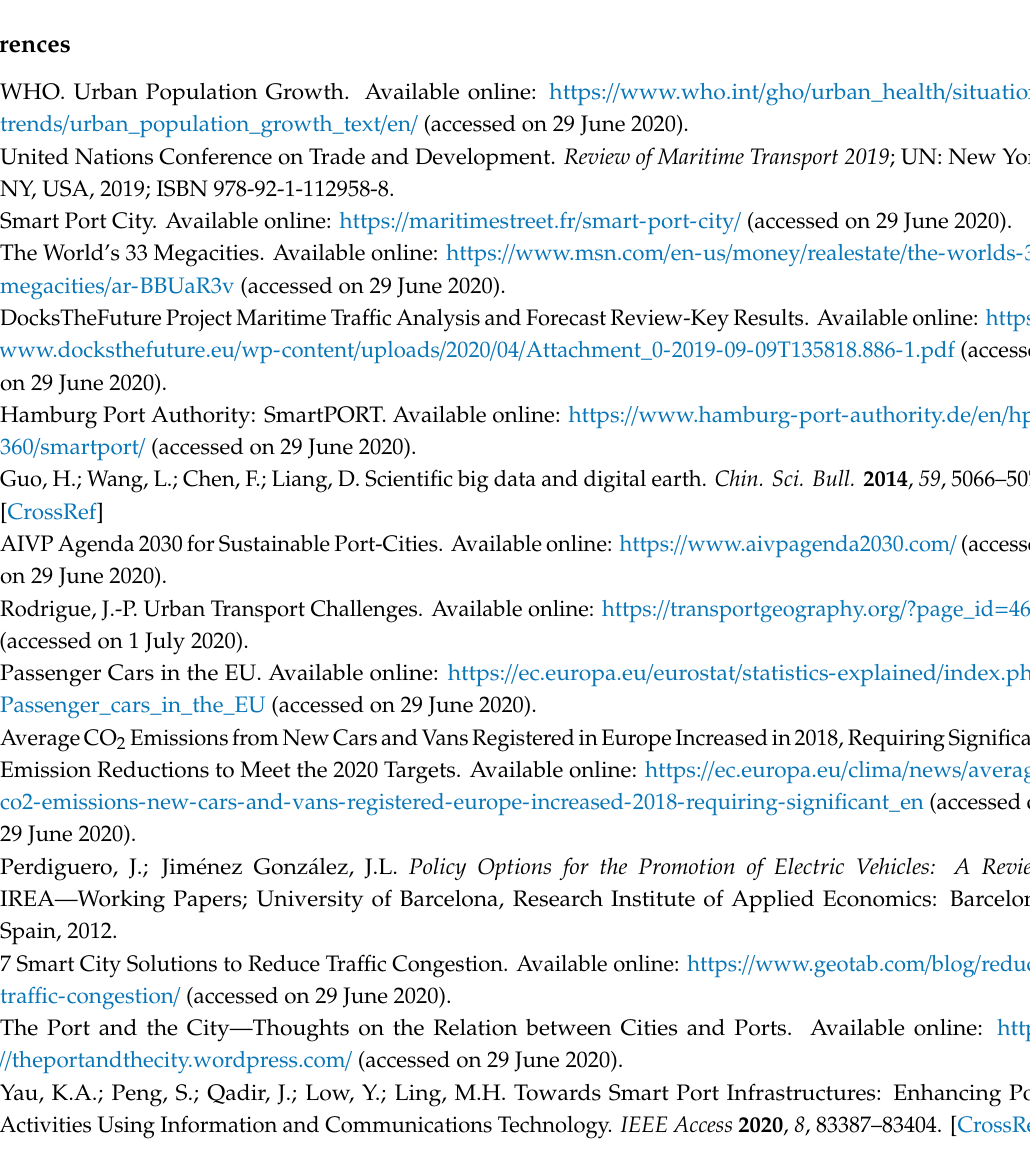
Figure A12. Visualization of the scenario 3.3 in the UI dashboard.